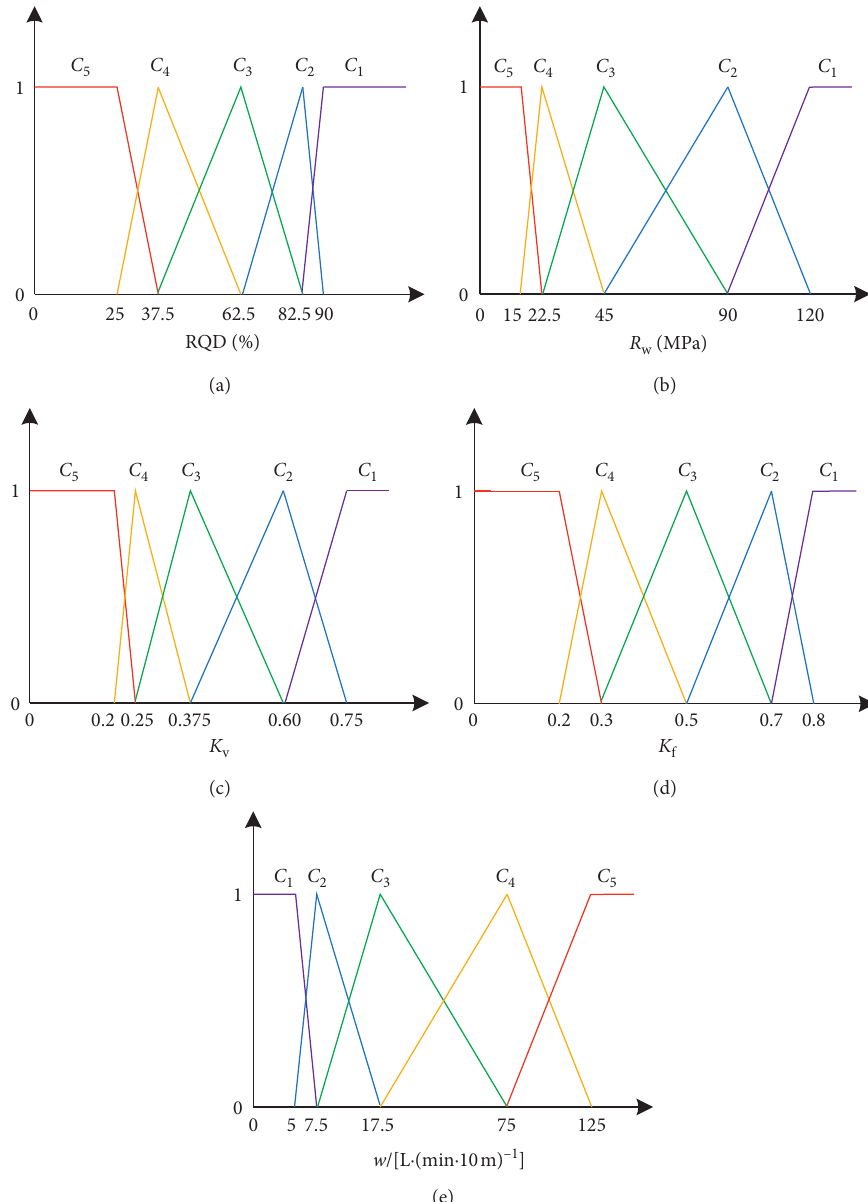
Figure 4: The single index measure